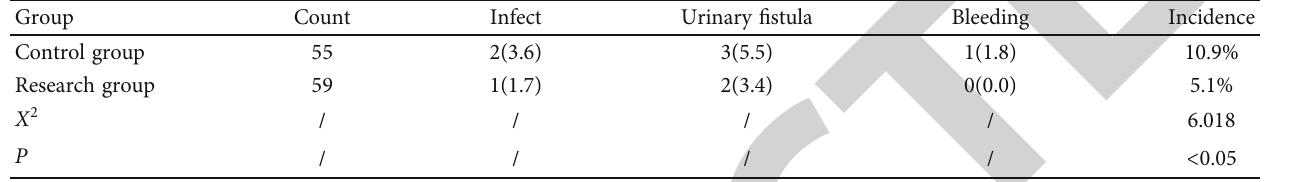
Table 2: Comparison of incidence of complications in two groups (example, %).